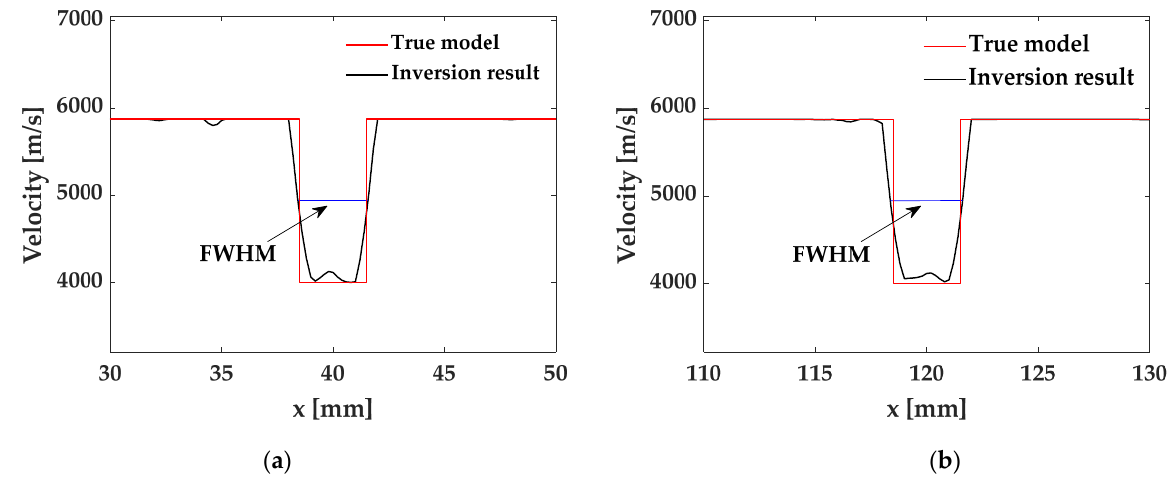
Figure 10. Cross sections of the reconstruction of the 3 mm diameter circular hole along the ( a ) horizontal and ( b ) vertical direction.